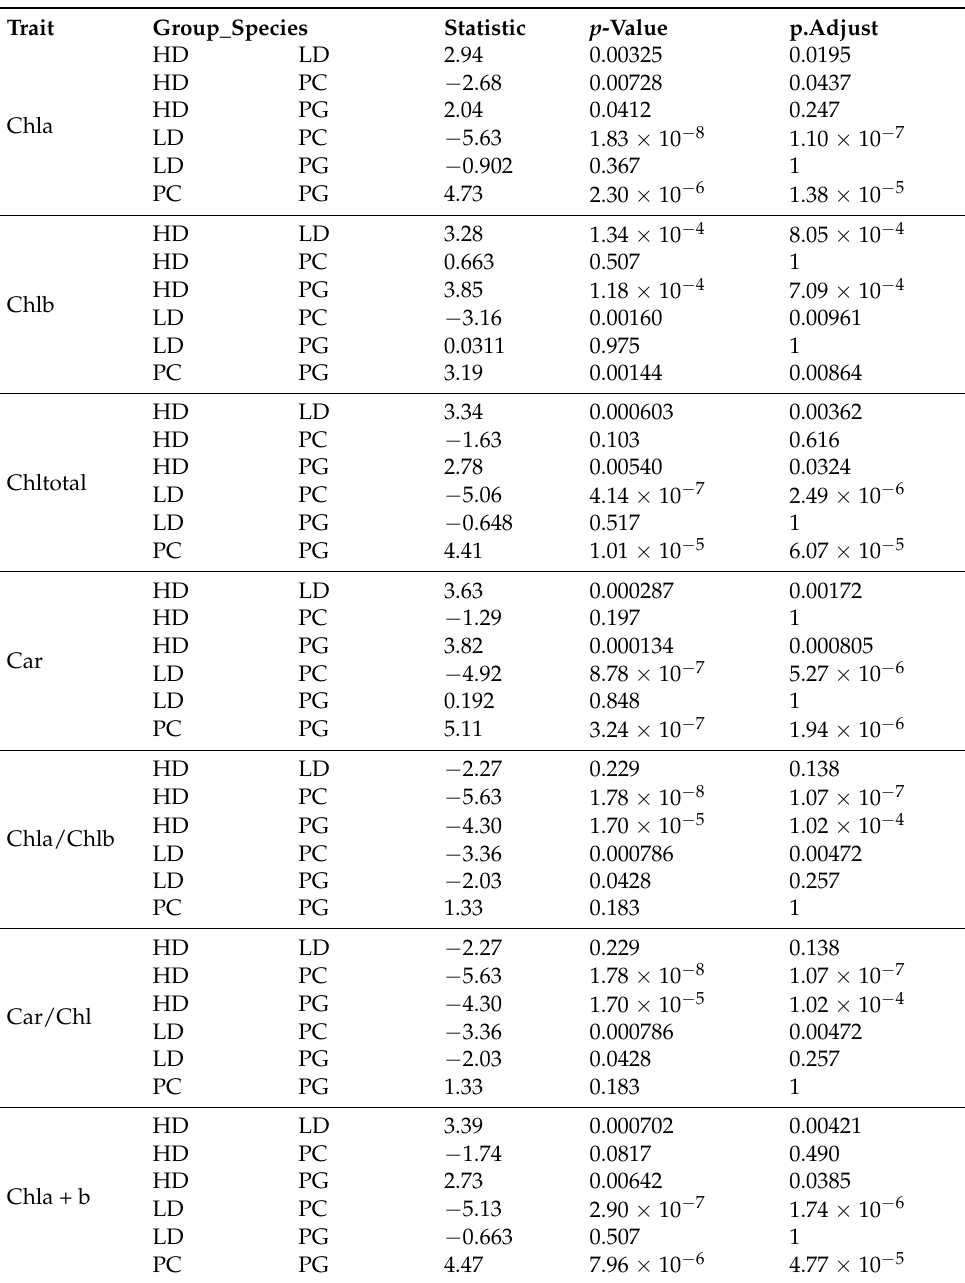
Table 7. Dunn post hoc test by the adjusted method Bonferroni of the 7 leaf traits Photosynthetic pigments: Chla ( µ g cm − 2 ) = chlorophyll a content; Chlb ( µ g cm − 2 ) = chlorophyll b content; Chl ( µ g cm − 2 ) = total chlorophyll content; Car ( µ g cm − 2 ) = carotenoid content; Chla/Chlb =